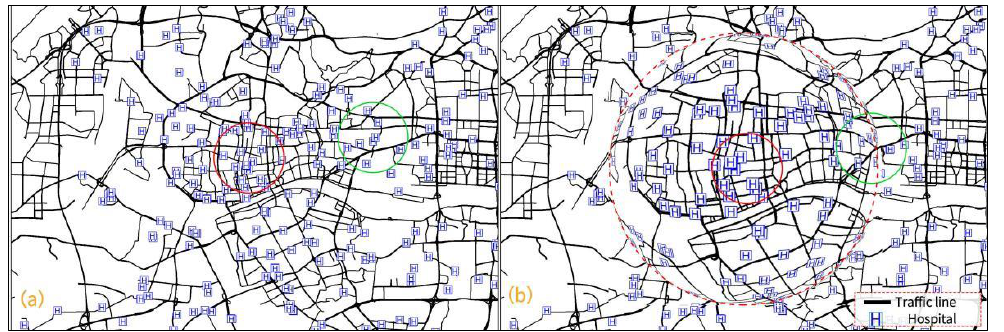
Figure 1. Variable-scale representation based on POIs and roads. ( a ) Original POI map. ( b )Variable-scale visualized POI map.